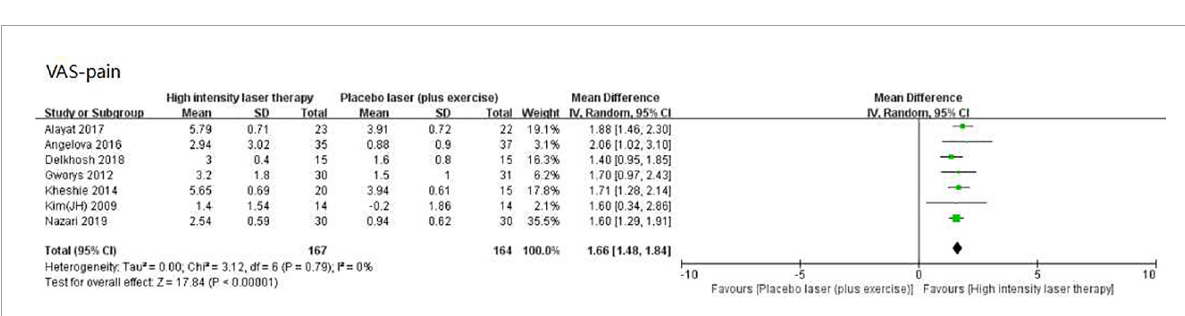
FIGURE5 Forest plot of the visual analog scale (VAS)-pain in high intensity laser therapy (HILT) vs. Placebo laser (plus exercise).